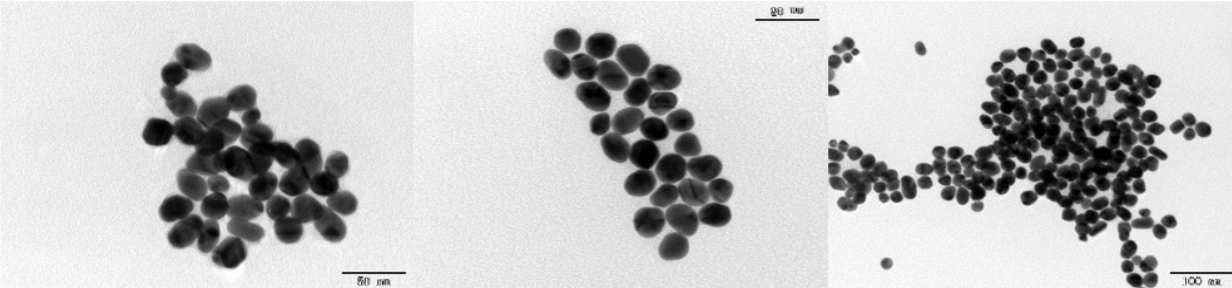
Figure 1. TEM images of Au nanofluids.